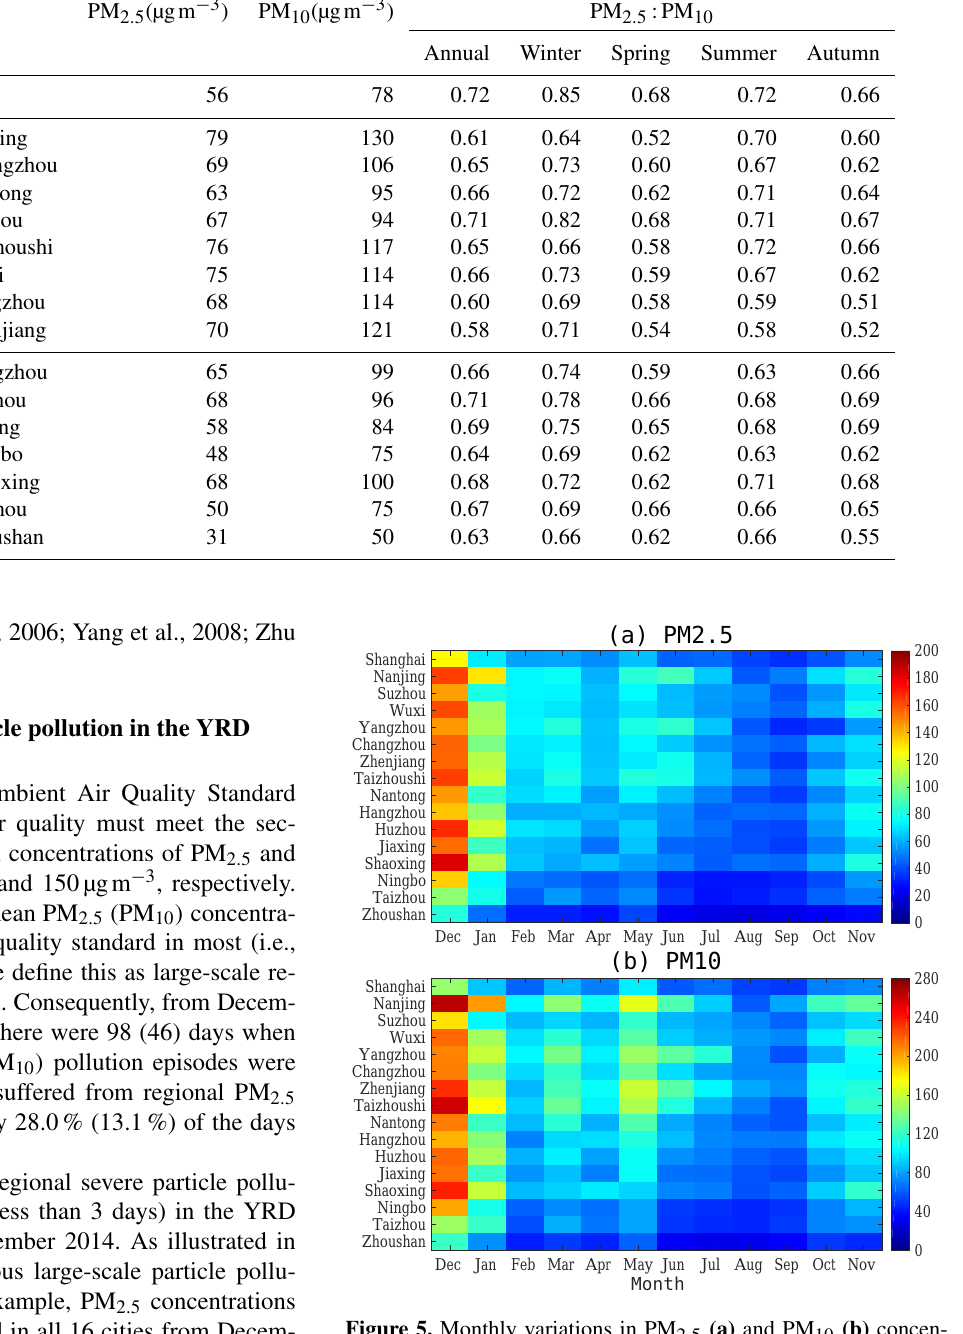
Figure 5. Monthly variations in PM 2 . 5 (a) and PM 10 (b) concen- trations in 16 cities of the YRD (unit: µgm − 3